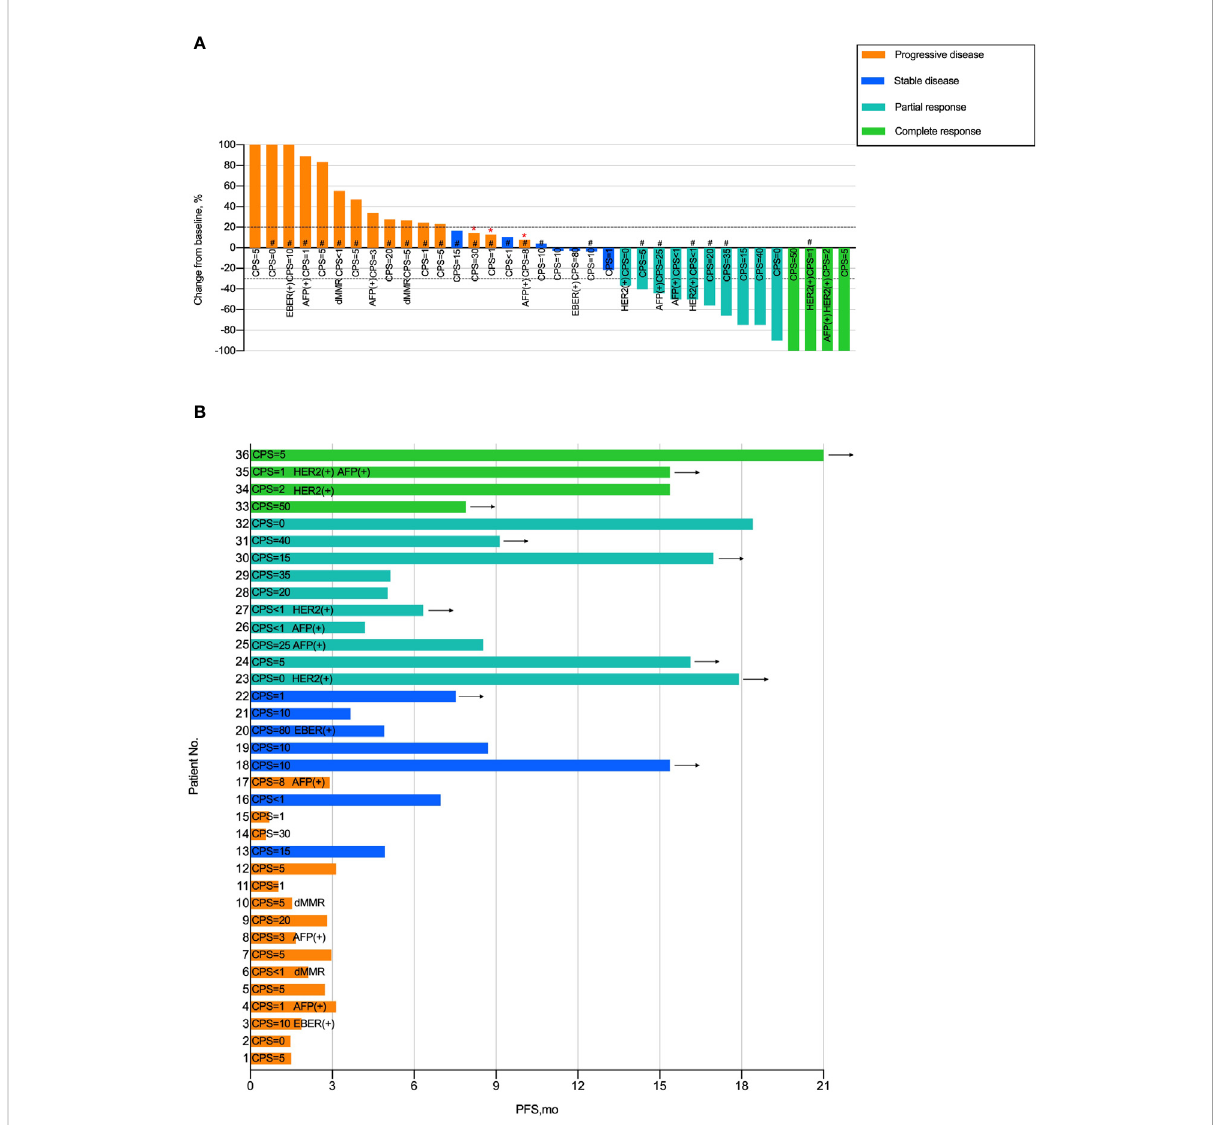
FIGURE 3 Tumor Response in Patients with Gastric Cancer Liver Metastases Treated with Immunotherapy (A) Waterfall plot of tumor response in patients with liver metastases in the I-LM(+) group. (B) Swimmer plot presentation of progression-free survival in patients with liver metastases in the I-LM(+) group. CPS, combined positive score; HER2, human epidermal growth factor receptor 2; dMRR, de fi cient of mismatch repair gene; EBER, Epstein – Barr virus-encoded regions. “ * ” Indicates new lesion. “ # ” Indicates presence of peritoneal metastases. Arrow indicates ongoing bene fi